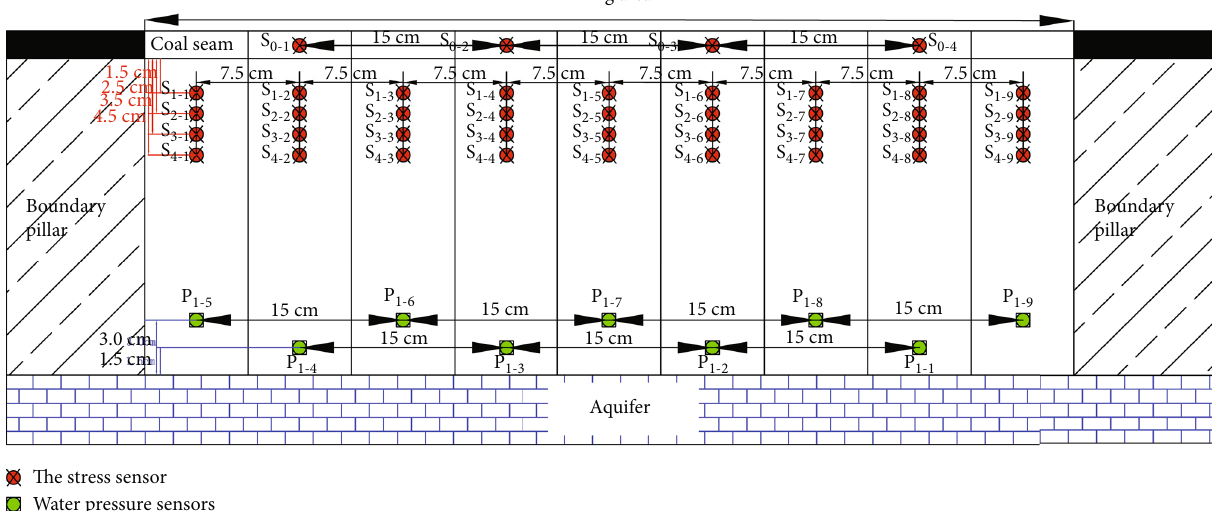
Figure 8: Front view of the monitoring point